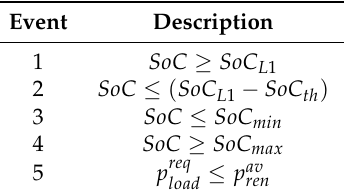
Table 5. Description of the events in the set Σ